Question: How would you classify this visualization?
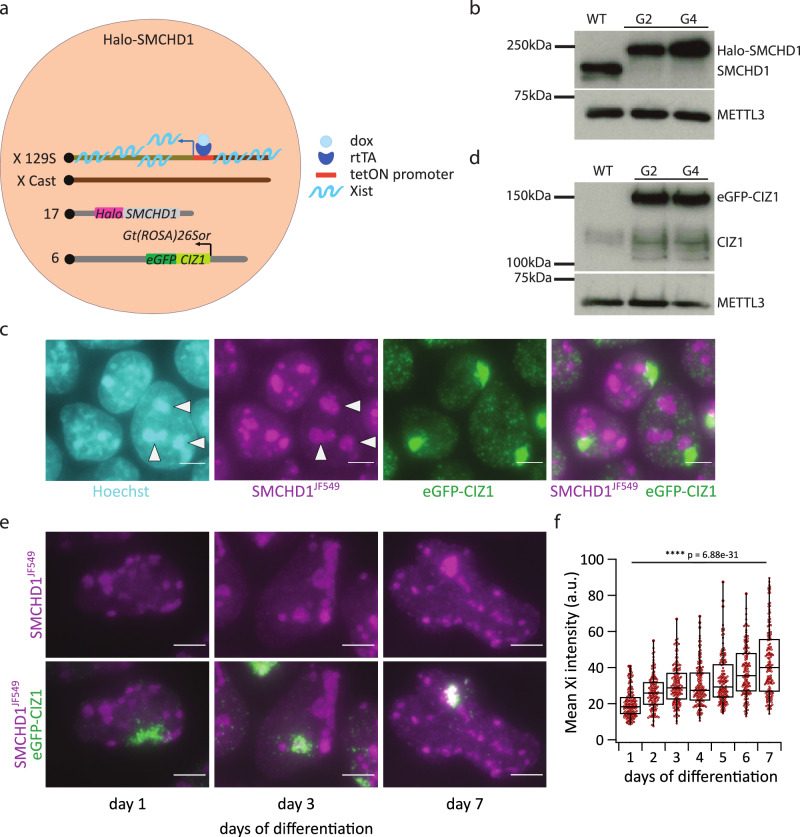
Answer: box